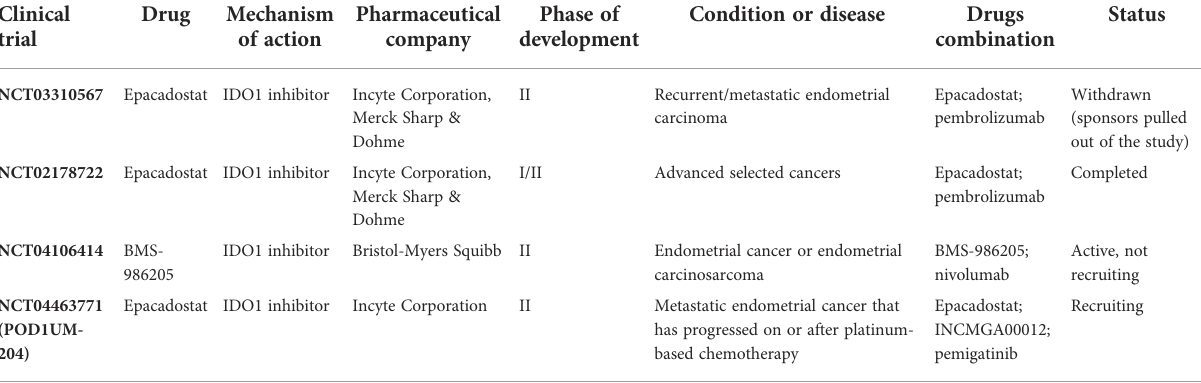
TABLE 1 Current development status of IDO1 inhibitor strategies in advanced endometrial cancer. Clinical